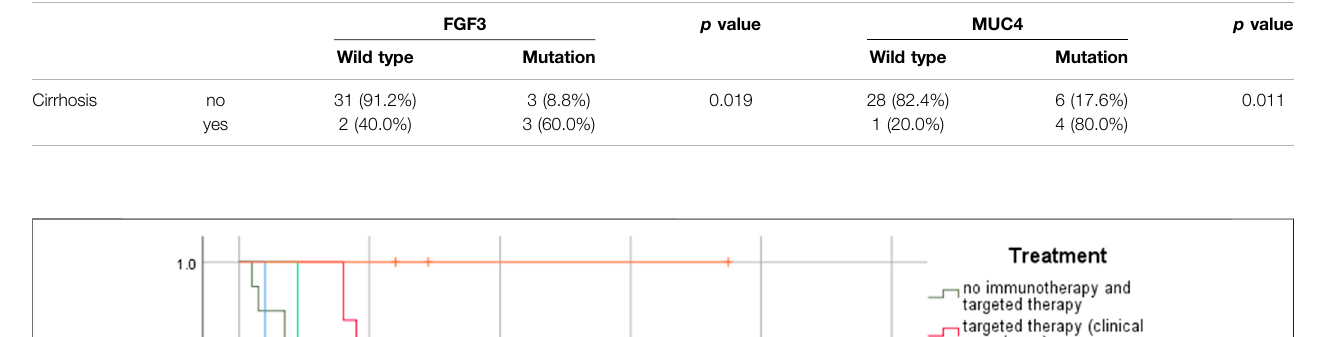
TABLE 4 | Correlations among FGF3 mutation, MUC4 mutation and cirrhosis.